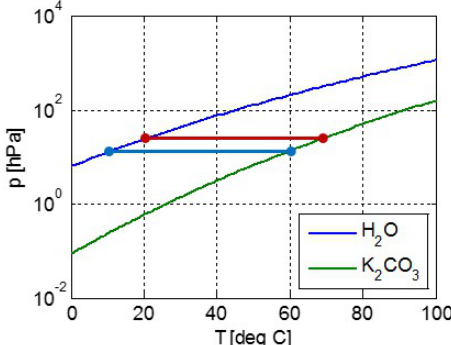
Figure 2. Vapor pressure lines of water (blue) and K 2 CO 3 ·(1½–0)H 2 O (green). The red horizontal line gives the vapor pressure of about 23 hPa for water at a typical condenser temperature of 20 °C. The intersection with the green line gives a minimum desorption temperature of K 2 CO 3 ·1½H 2 O of about 68 °C. The blue horizontal line gives the vapor pressure of about 12 hPa for water at a typical evaporation temperature of 10 °C. The intersection with the green line gives the maximum sorption temperature of K 2 CO 3 ·1½H 2 O of about 60 °C.